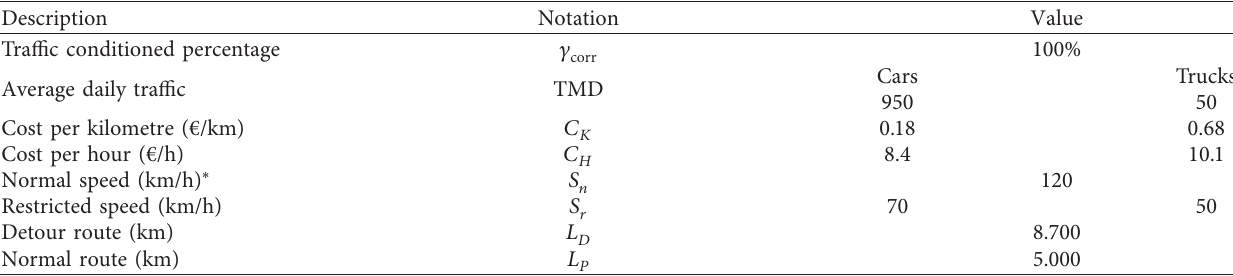
Table 13: Variable quantification for indirect